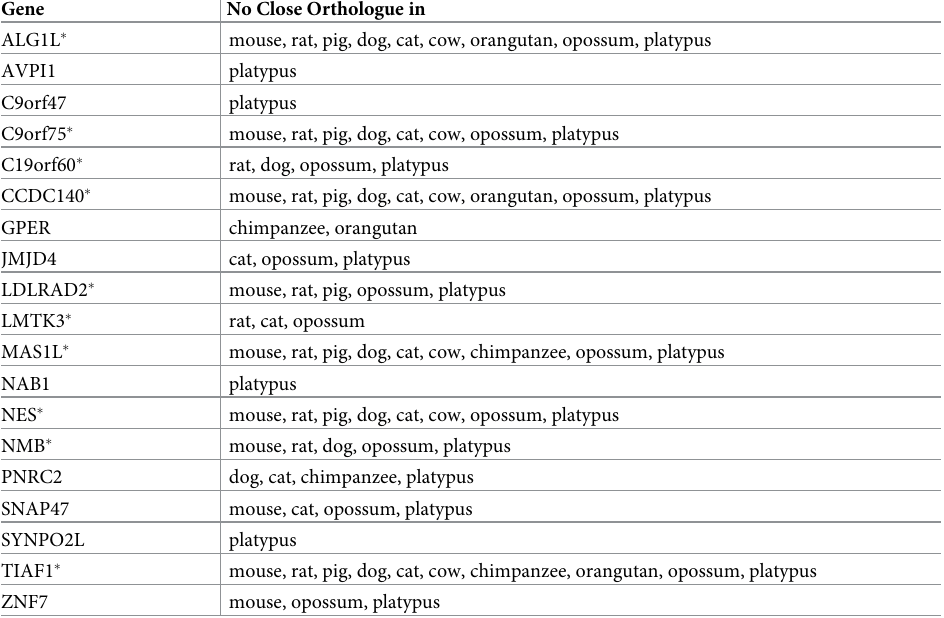
Table 2. Overall differences between 10 vertebrate species and human with respect to the 19 non-uniformly con- served human proteins both in EC and SMC. ( � denotes absence of mouse orthologue, 10 out of 19). Gene No Close Orthologue in ALG1L � mouse, rat, pig, dog, cat, cow, orangutan, opossum, platypus AVPI1 platypus C9orf47